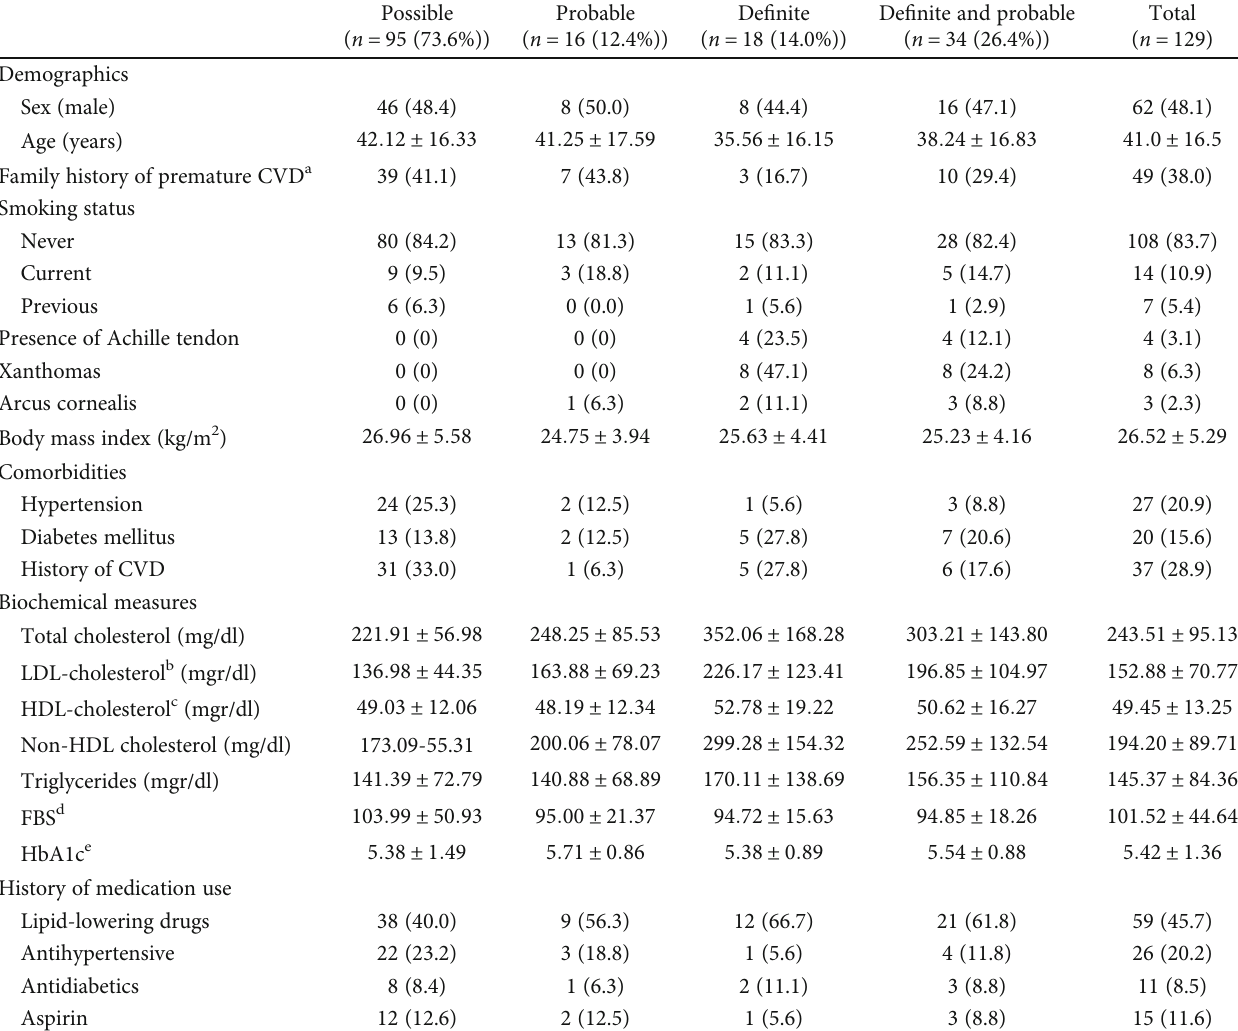
Table 3: Baseline characteristics of subjects with familial hypercholesterolemia by cascade screening.